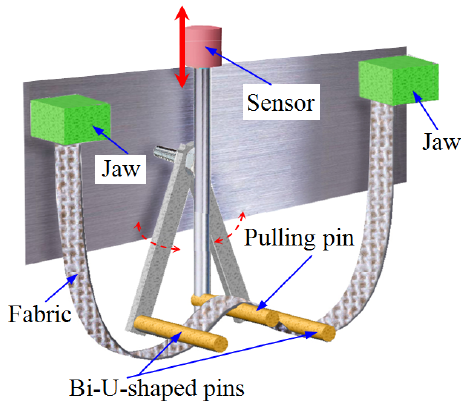
Figure 3. The schematic structure of the Comprehensive Handle Evaluation System for Fabrics and Yarns (CHES ‐